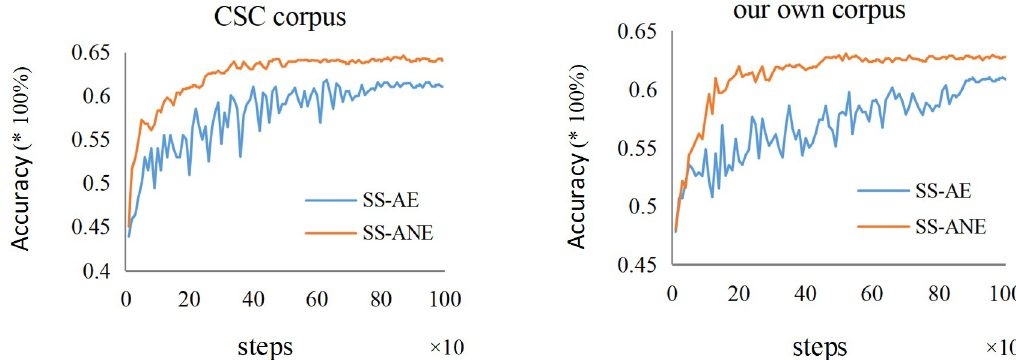
Fig 4. Accuracy rate of SS-ANE and SS-AE on the test set in two corpuses.